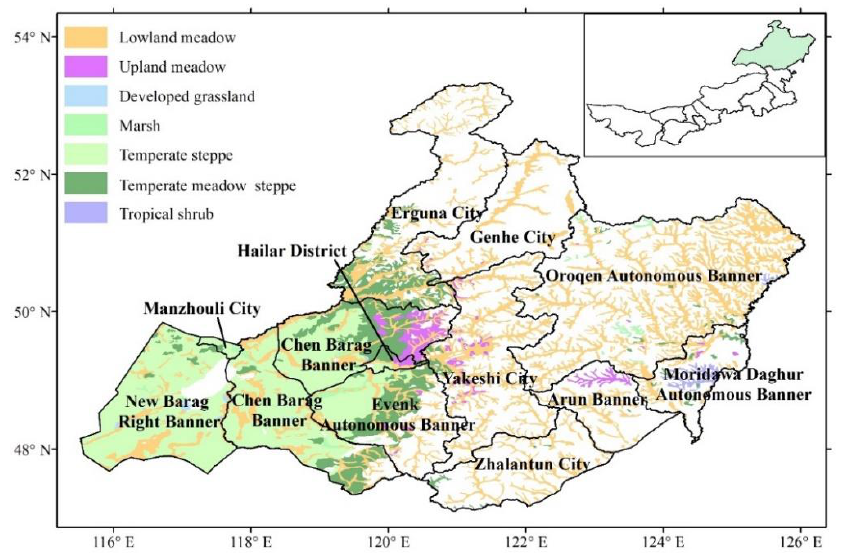
Figure 3. Administrative divisions and grassland classification in Hulun Buir. In this figure, county boundaries were used to divide the different districts. The name of each administrative district is given in bold. The blank areas represent non-grassland areas. The grassland classification dataset is based on a 1:1,000,000 Vegetation Atlas of China [49].